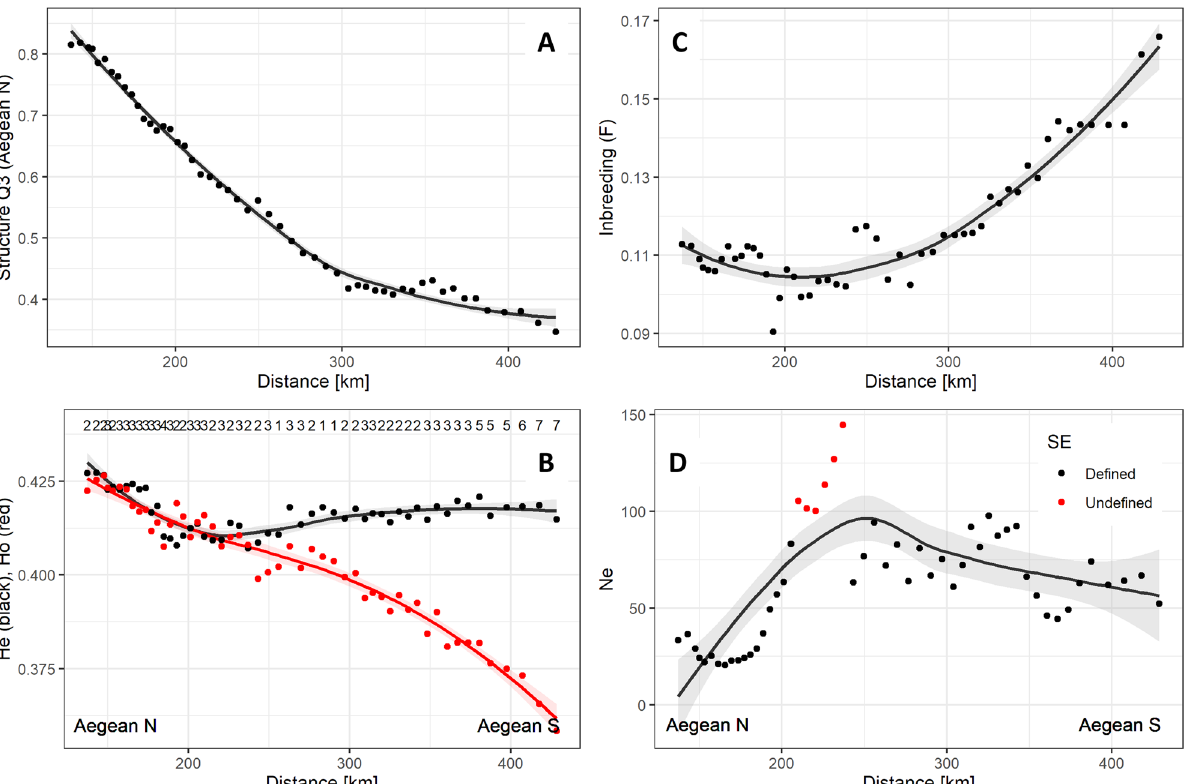
Figure 3. Hardy–Weinberg Dynamic Subsampling analysis results for Mediterranean monk seals in the Aegean Sea. “Distance” is the distance along the travelling window (TW) axis (see Fig. 1C). ( A ) Structure assignment probability to the Aegean North (Q3); ( B ) Expected ( He ; black) and observed ( Ho ; red) heterozygosity estimates for Mediterranean monk seals in the Aegean Sea. The numbers on the top indicate the number of loci out of Hardy Weinberg Equilibrium at P < 0.05. ( C ) Individual inbreeding estimates (TrioML estimate) along the TW axis; ( D ) Effective population size estimates along the TW axis. Red dots indicate estimates where Standard Error (SE) could not be reliably